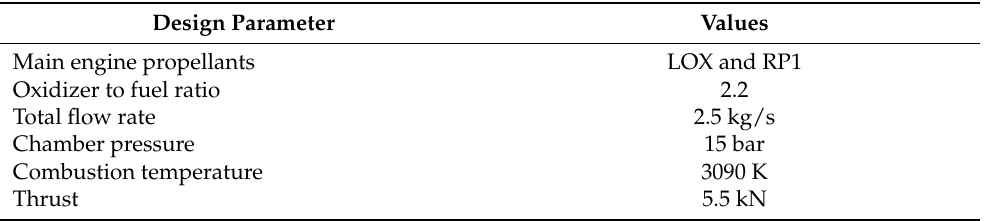
Table 1. Main rocket engine design